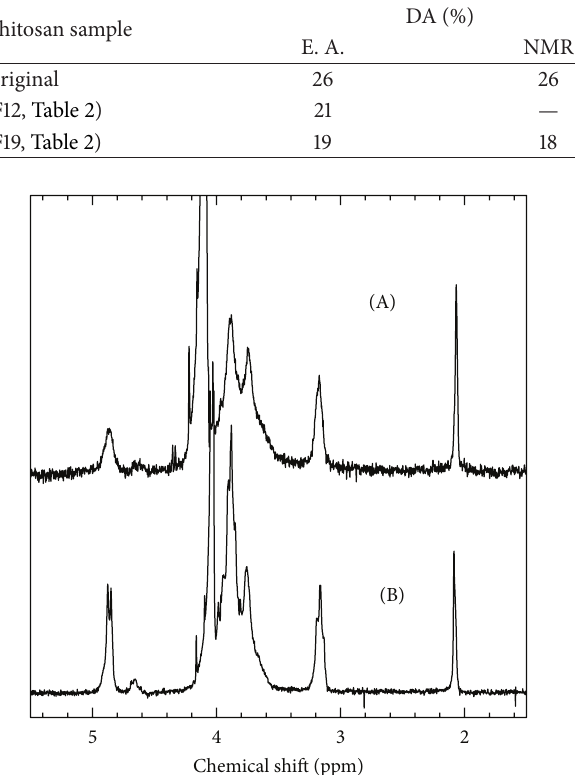
Table 3: Degree of acetylation (DA) for original chitosan and two fragments as determined by elemental analysis (E. A.) or 1 H NMR.